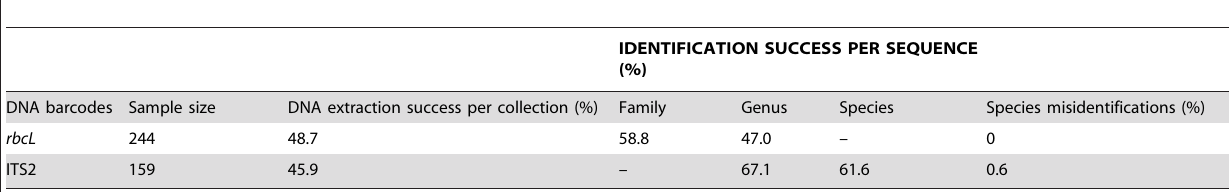
Table 1. Percent of success extracting plant DNA from gut contents and identification success of the resulting DNA sequences for the DNA barcodes rbcL and